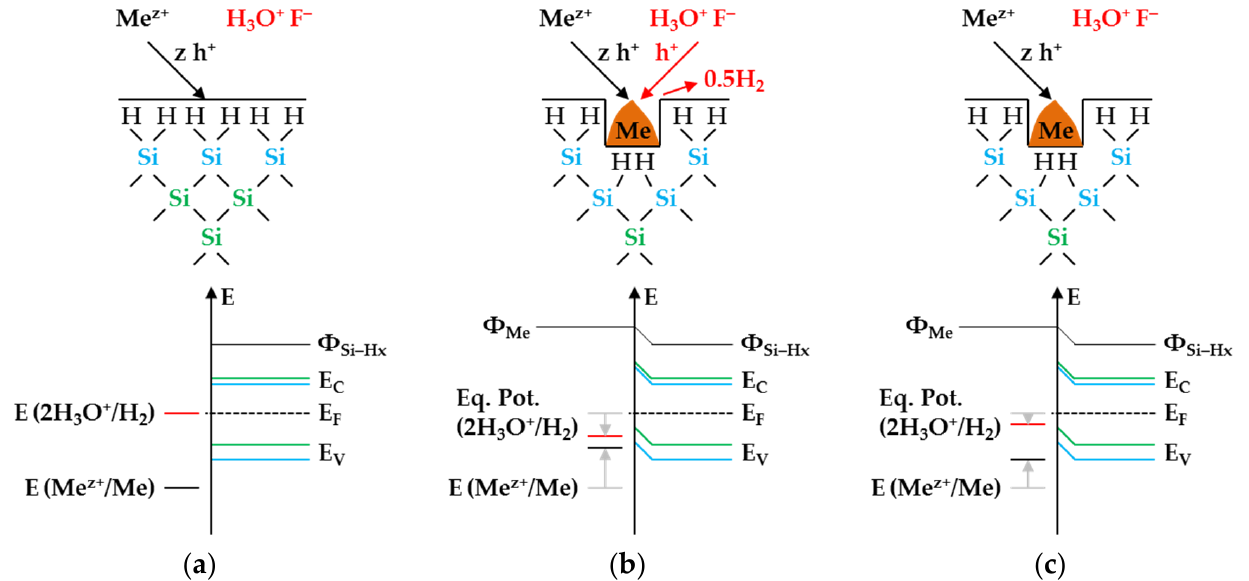
Figure 1. Simplified reaction and energy schemes of the metal ion/metal (Me z+ /Me) and 2H 3 O + /H 2 half-cells in the presence of silicon, showing the energetic levels of the valence and conduction bands of the bulk silicon (green) and the hydrogen-terminated silicon (blue) ( a ) before metal deposition, ( b ) after initial metal deposition at the metal/silicon contact with an equilibrium potential of the 2H 3 O + /H 2 half-cell ( Eq. Pot. (2H3O + /H 2 )) in the range of the energy level of the silicon valence bands and ( c ) out of the energy level of the silicon valence bands.